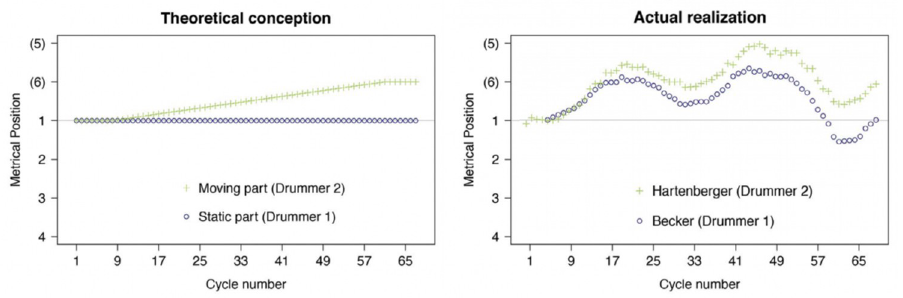
Fig 1. Theoretical versus actual phasing performance. Left : How phasing would occur, in theory, if partners were uninfluenced by each other’s performance. The static part (blue) remains constant, while the moving part (green) steadily shifts its metrical position. Right : Actual performance of “Drumming” by Becker and Hartenberger. The “static” part actually varies along with the moving part during phasing. In other words, the drummer who intended to maintain the original tempo was unable to do so; instead, this drummer unintentionally increased and decreased their tempo along with the phasing drummer. (Figure reproduced with permission from Schutz